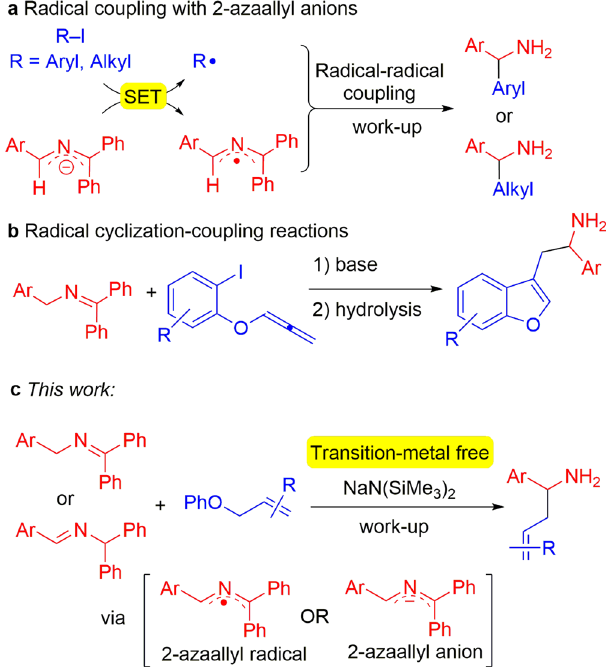
Fig. 2 Transition-metal-free reactions of 2-azaallyl anions. a SET with aryl or alkyl iodides followed by radical – radical coupling. b SET from 2-azaallyl anions, cyclization and radical – radical coupling to afford benzofurans. c Allylation of 2-azaallyl anions (this